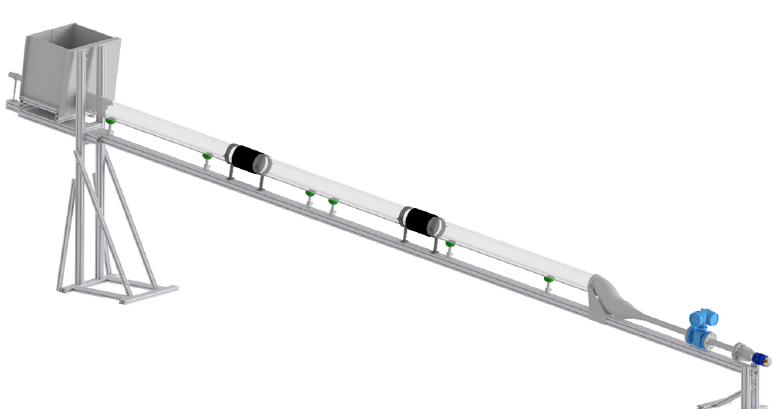
Figure 2. 3D CAD view of the reduced scale model (scale 1:20) used for the investigation of the air entrainment during the emptying of the forebay tank and the head race tunnel.